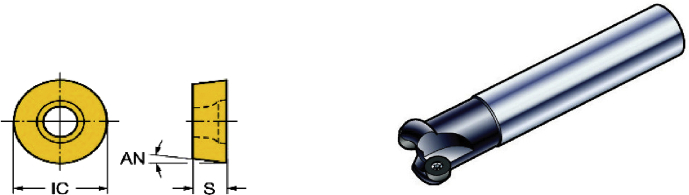
The insert blades and tool-holders.